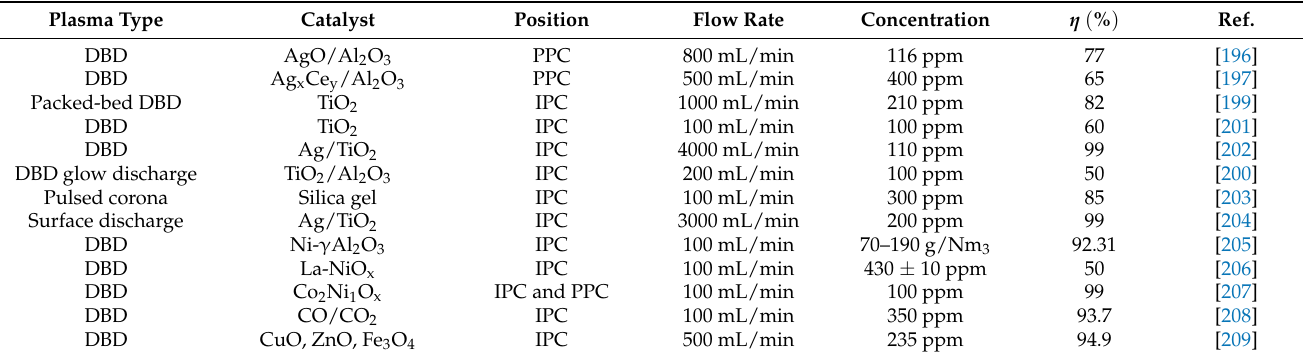
Table 4. Summary of the plasma-catalytic benzene